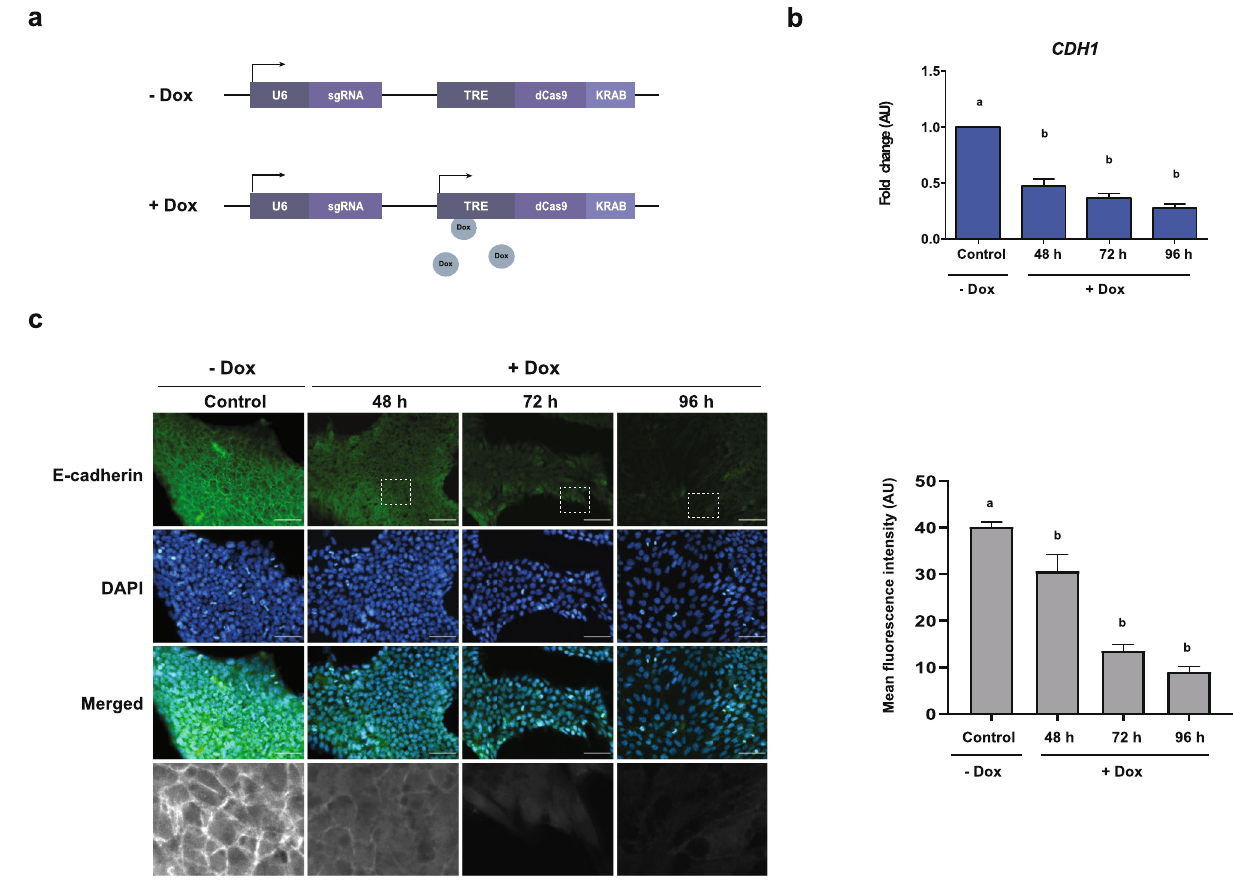
Figure 1. Characterization of HES3-KRAB CDH1 clonal cell line. ( a ) Schematic representation showing the construct used for generation of HES3-KRAB CDH1 cell line. This knockdown system contains a deactivated Cas9 (dCas9) fused to a transcriptional repressor domain Krüppel Associated Box (KRAB) under the control of TRE promoter inducible by Dox. A sgRNA against CDH1 promoter was placed under the control of the U6 promoter which is constitutively activated. In cells not treated with Dox, the system is not active. Upon Dox induction, dCas9-KRAB is expressed and targeted to CDH1 promoter by the sgRNA to produce transcriptional repression of E-cadherin. ( b ) Relative mRNA levels of E-cadherin ( CDH1 ) in cells after incubation with Dox at different times assessed by qPCR. AU is the abbreviation for arbitrary units. Results are represented as mean ± SD (n = 5). Different letters indicate significant differences of groups compared to control condition (p < 0.001) for ANOVA with post hoc Tukey. ( c ) Left panel: immunofluorescence images of E-cadherin protein (green) in cells incubated with Dox during 48, 72 and 96 h. Nuclei were stained with DAPI (blue). Magnification of the indicated areas are shown in black and white at the bottom of the panel. Representative images of at least three experiments are shown. Scale bar 50 µm. Right panel quantification of the mean fluorescence intensity of three images from three independent experiments. Results are represented as mean ± SD (n = 3). Different letters indicate significant differences of groups compared to control condition (p < 0.0001) for ANOVA with post hoc